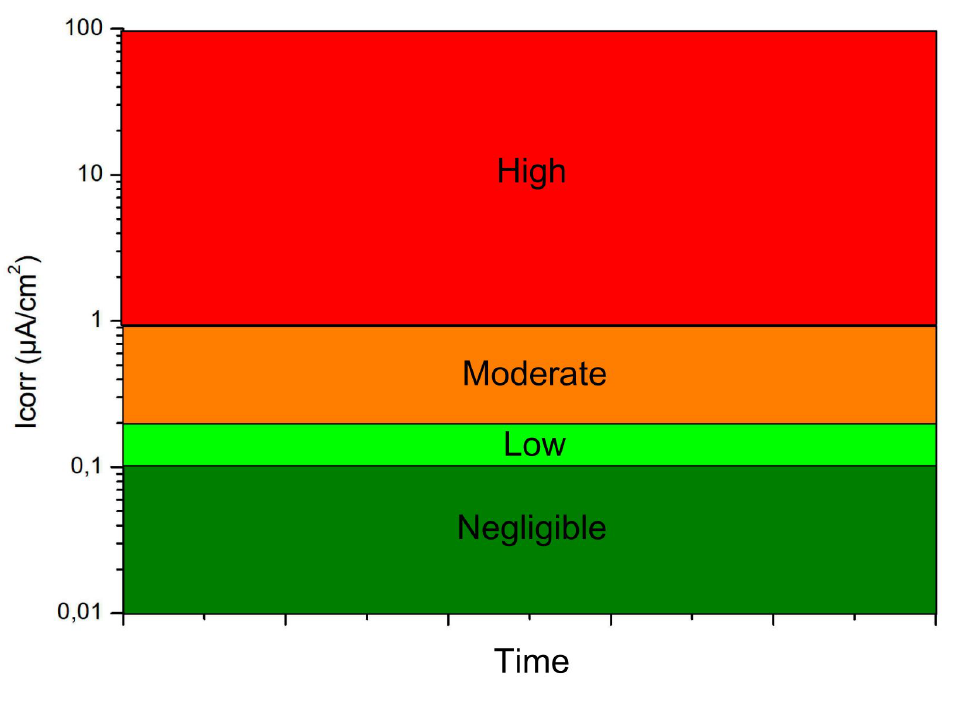
Figure 2. Corrosion rate classification